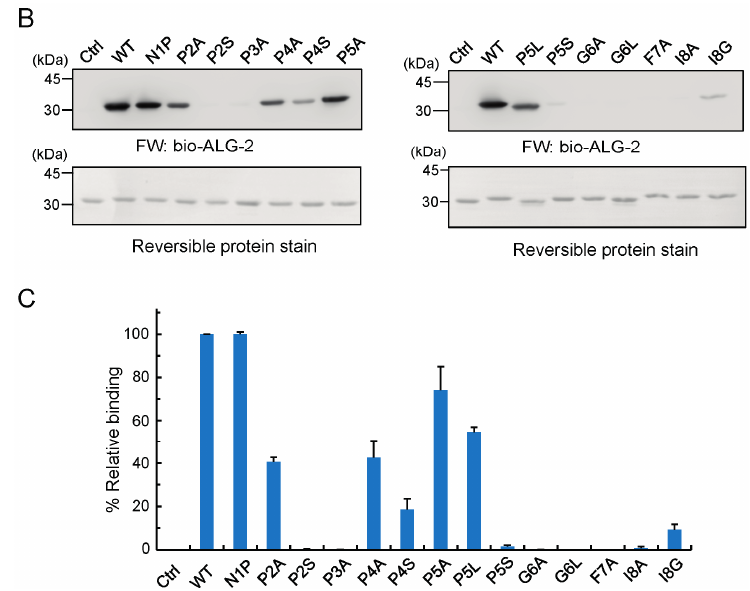
Figure 8. Determination of critical residues in the Sec31A peptide sequence for ALG-2 interactions. ( A ) Amino acid sequences of the GST-fusion vector in the cloning site and mutant Sec31A peptides. Escherichia coli expression plasmids for amino acid-substituted mutants of eight-residue Sec31A peptides were generated by inserting each synthetic oligonucleotide block into a GST-SGG-linker-8xHis vector; ( B ) Far-Western blot analysis. Affinity-purified control GST (Ctrl) and Sec31A peptide-fused GST proteins of wild-type (WT) and mutants were resolved by SDS-PAGE, transferred to PVDF membranes and stained with a reversible protein stain kit ( lower panels). After being destained, the membranes were subjected to FW by probing with bio-ALG-2 ( upper panels). Representative data from four independent experiments are shown; ( C ) Relative binding activities of mutants. The signal intensity of FW was measured with image processing software ImageJ. Relative binding activities compared to WT were calculated and expressed in percentages (mean ± S.E.; n =